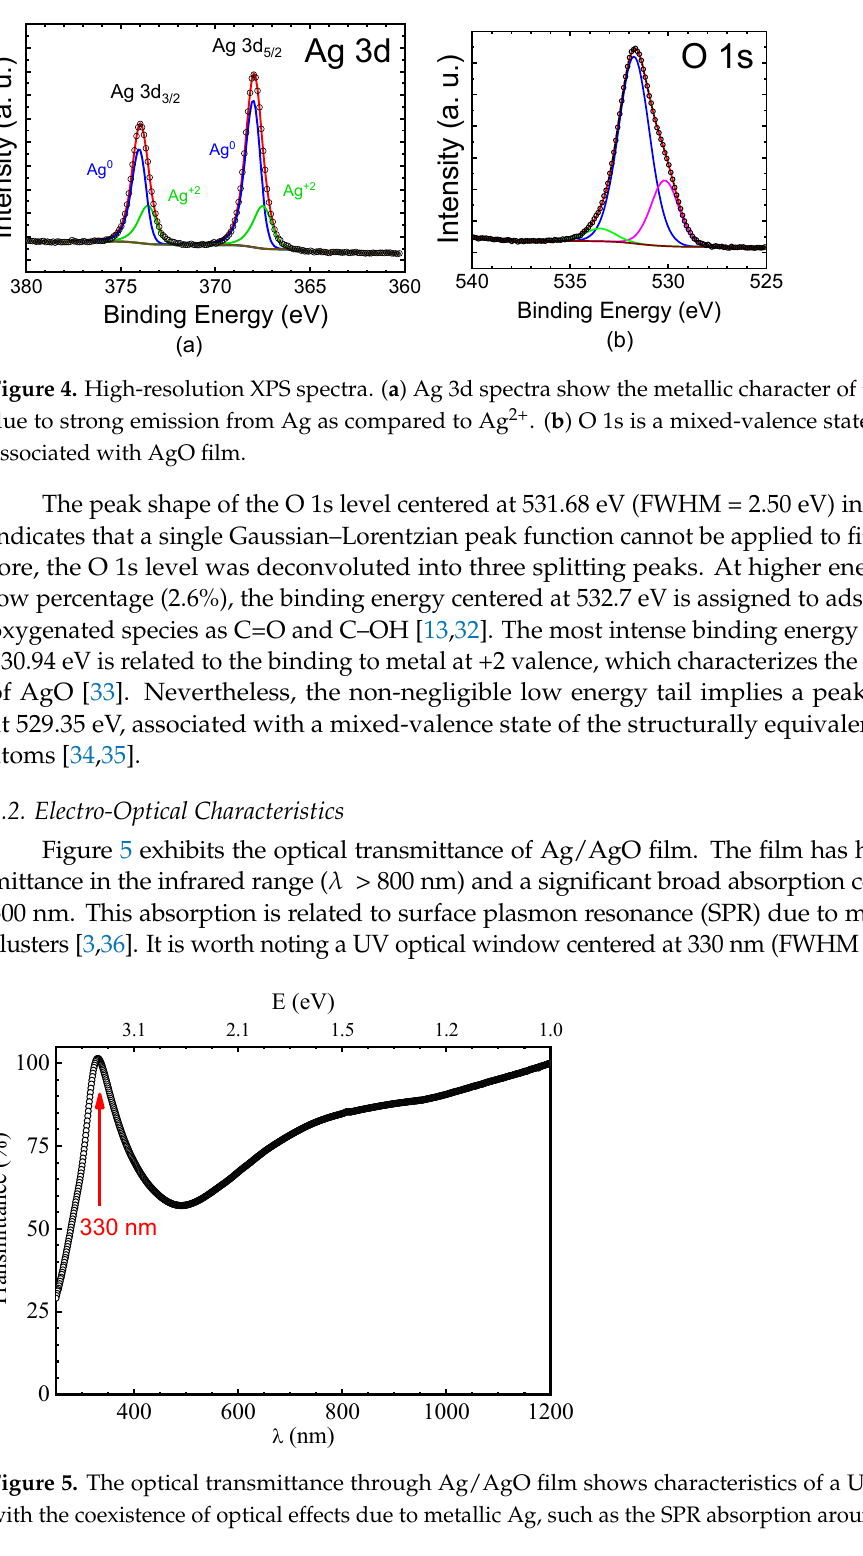
5 Figure 3. Scanning electron microscopy images show films with extended grooves ( a ) and the pres ‐ ence of small silver microcrystallites ( b ) with cubic structure ( c ). High ‐ resolution XPS was employed to analyze the chemical state of the Ag/AgO film surface. Figure 4a shows the Ag 3d and O 1s (Figure 4b) spectra. Figure 4a shows two strong sharp peaks at 367.98 eV (with full width at half maximum—FWHM = 1.01 eV) and